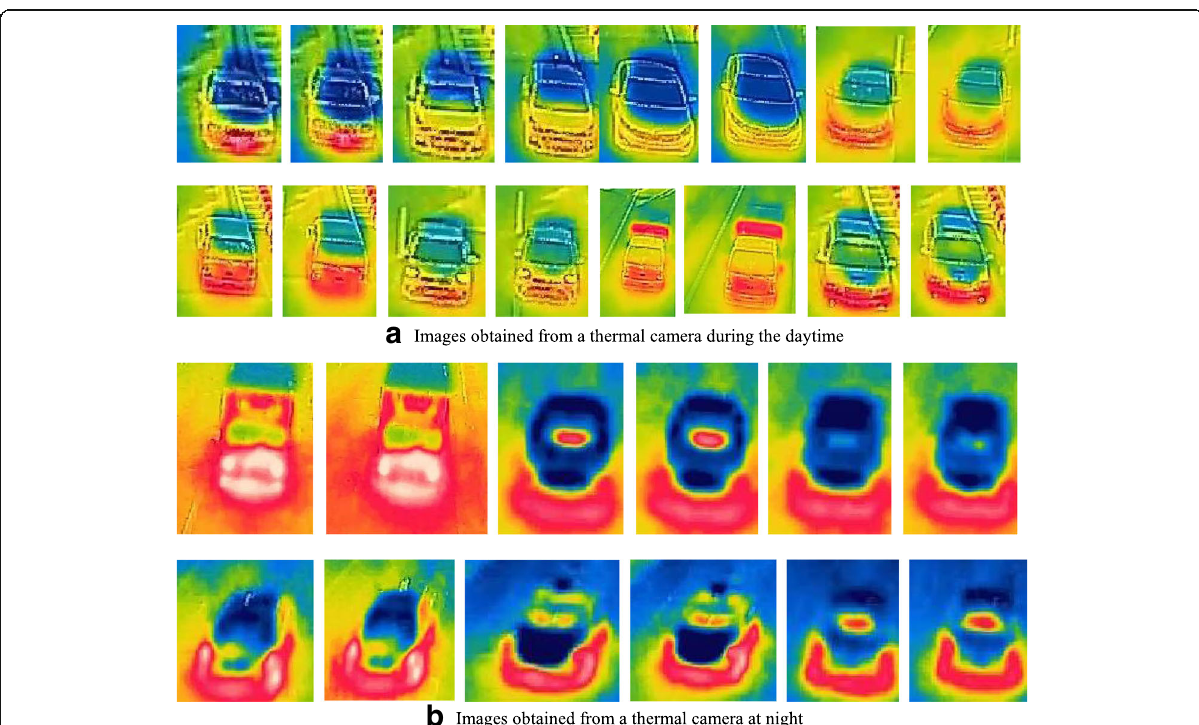
Fig. 7 Images obtained from a thermal camera in the daytime and at night. a Images obtained from a thermal camera during the daytime. b Images obtained from a thermal camera at